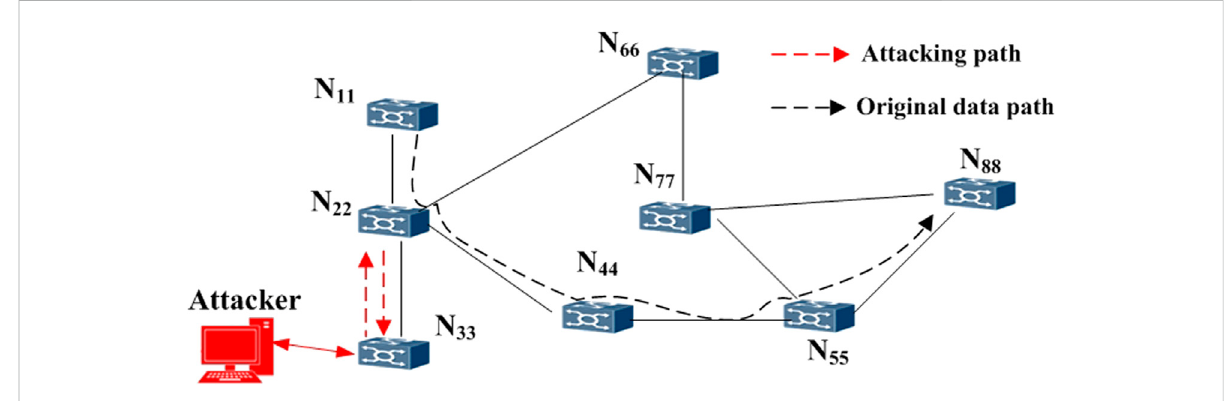
FIGURE 2 The topology of communication